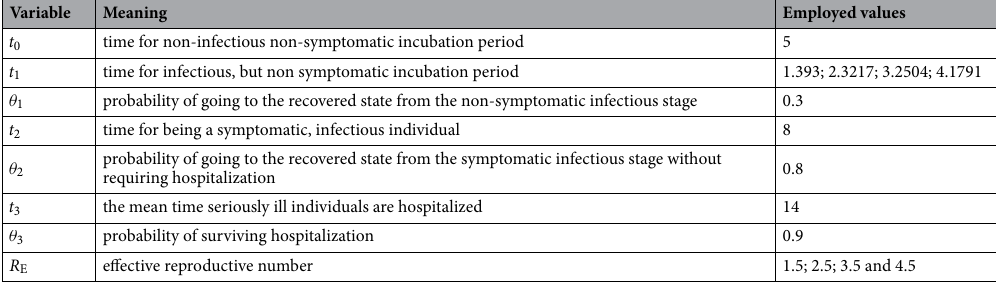
Table 1. Variables and parameters of the model (times in